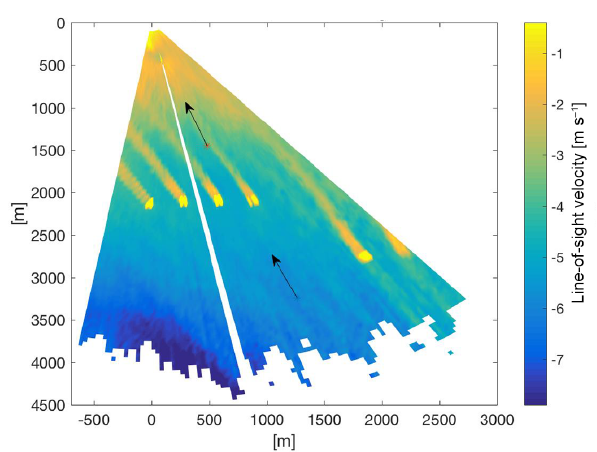
Figure 8. Radial velocity v R measured by a Doppler LiDAR [118]. The LiDAR is located at the origin of the Cartesian coordinate system. The arrows indicate the wind direction.